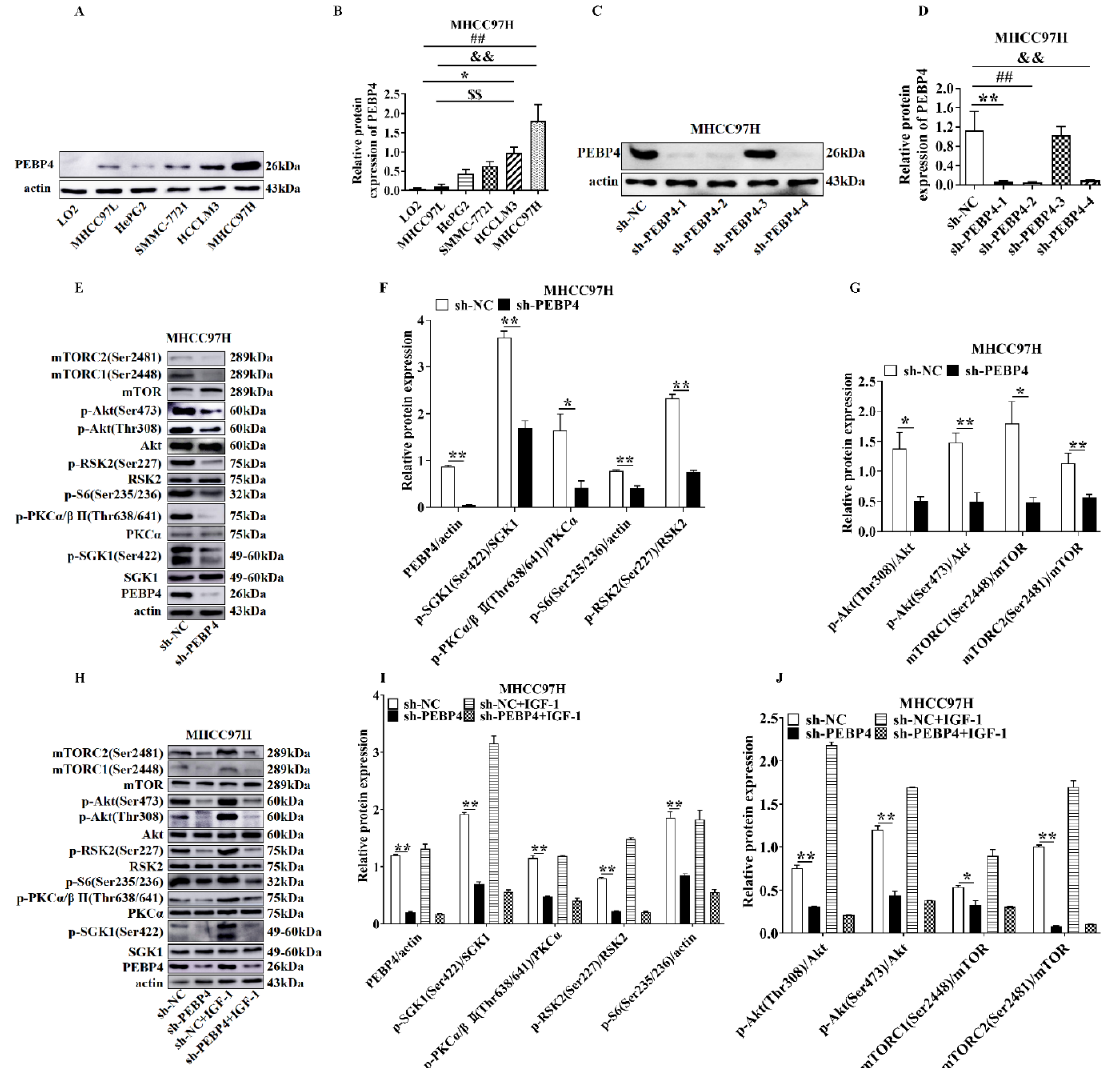
Figure 1. The effect of PEBP4 knockdown on the mTORCs-mediated signaling pathways. ( A ) Western blot (WB) was performed using different HCC and immortalized normal hepatocytes as indicated. ( B ) Scan densitometric ratio of PEBP4 to actin. ( C , D ). MHCC97H cells were infected with sh-NC and different PEBP4 shRNA1-4. Cell extracts were blotted ( C ) and quantified by scan densitometry ( D ). ( E ) Extracts of MHCC97H cells with sh-PEBP4 and sh-NC were blotted with antibodies. ( F , G ) Relative scan densitometric units were determined by the ratio of phospho-proteins to their cognate total proteins or actin for ( E ). ( H ) MHCC97H cells with sh-PEBP4 or sh-NC were treated with or without IGF-1 (100 µg/mL) for 30 min and WB was performed using antibodies. ( I , J ) Relative scan densitometric units were determined for H. All graphs represent averages of three independent experiments (mean ± SEM). * p < 0.05, ** p < 0.01, ## p < 0.01, && p < 0.01, $$ p < 0.01.